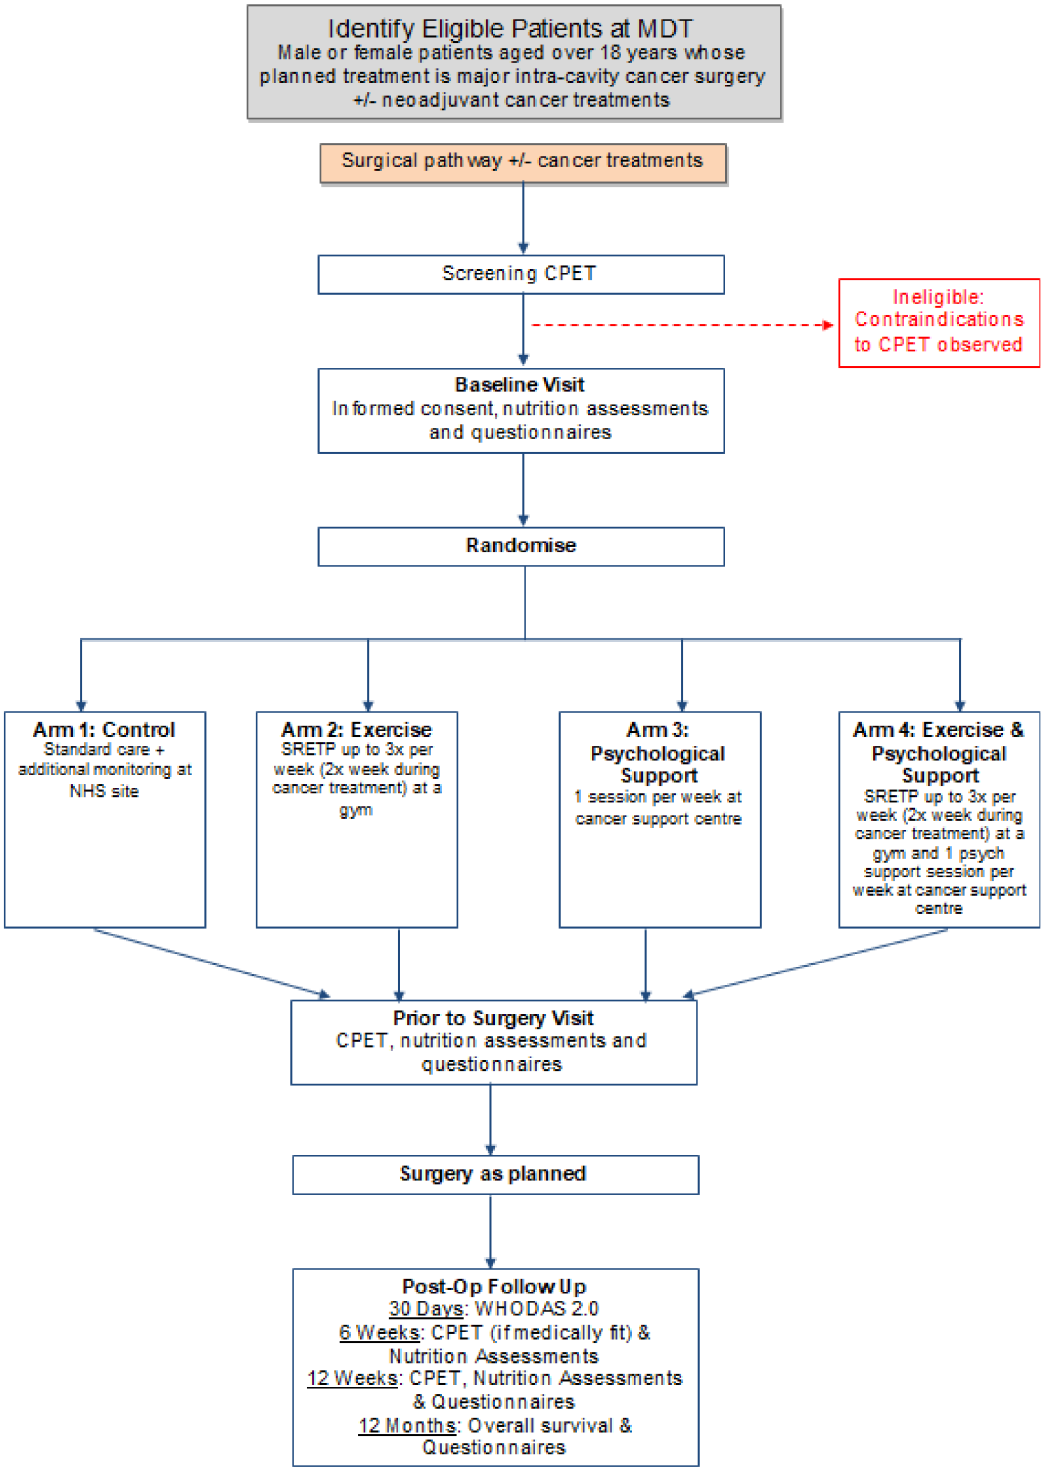
Figure 1. Trial summary diagram. MDT: multidisciplinary team, CPET: cardiopulmonary exercise test, SREPT: structured responsive exercise training programme, WHODAS: World Health Organisation Disability Adjusted